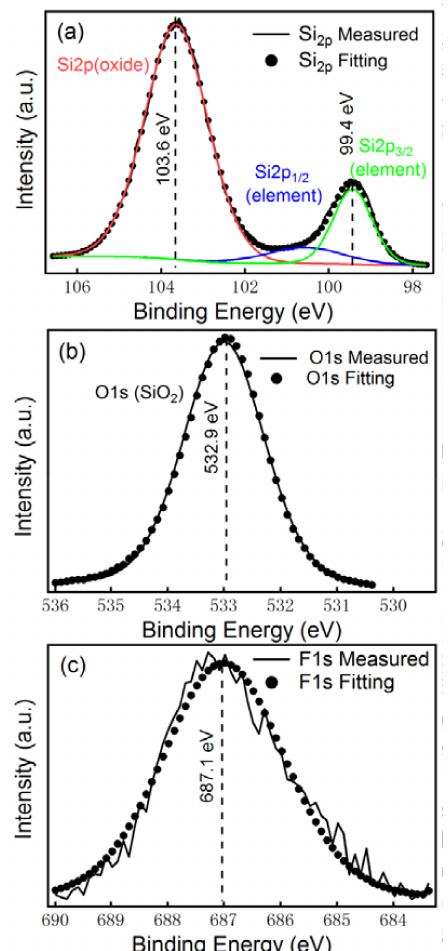
Figure 5. X-ray photoelectron spectroscopy (XPS) survey of 1D–PSiNWs using ( a ) Si 2p , ( b ) O 1s , and ( c ) F 1s